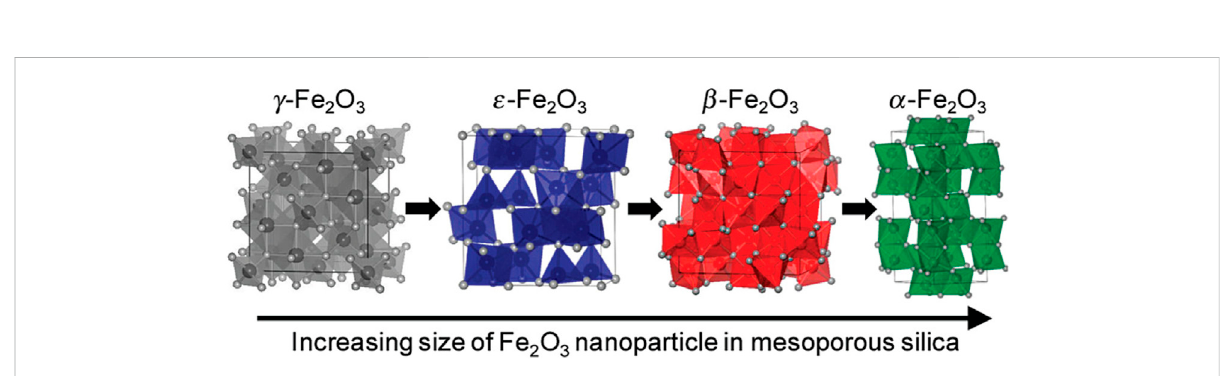
FIGURE 5 Schematic diagram of the structure of four different crystal forms of Fe 2 O 3 , (the colored ball in the center of the polyhedron represents the Fe atom, and the white atom on the edge represents the oxygen atom (Sakurai et al.,